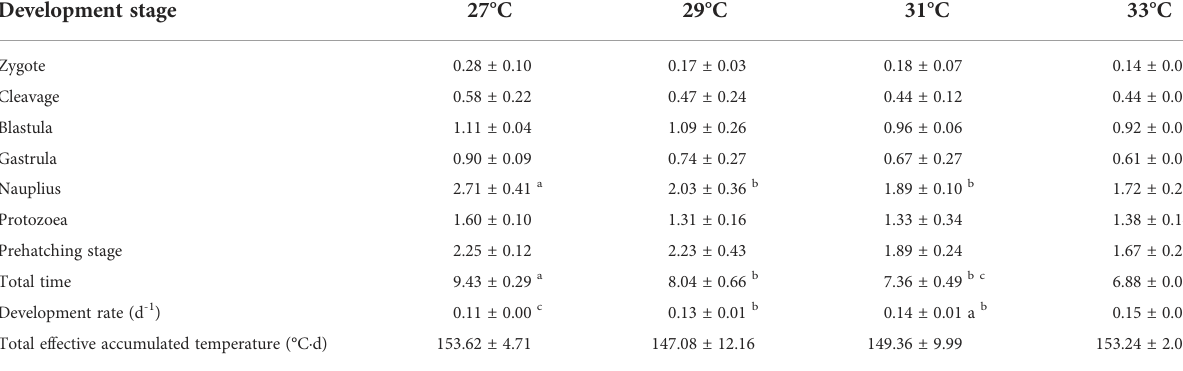
TABLE 1 The embryonic development time and effective accumulated temperature of swimming crab at four water